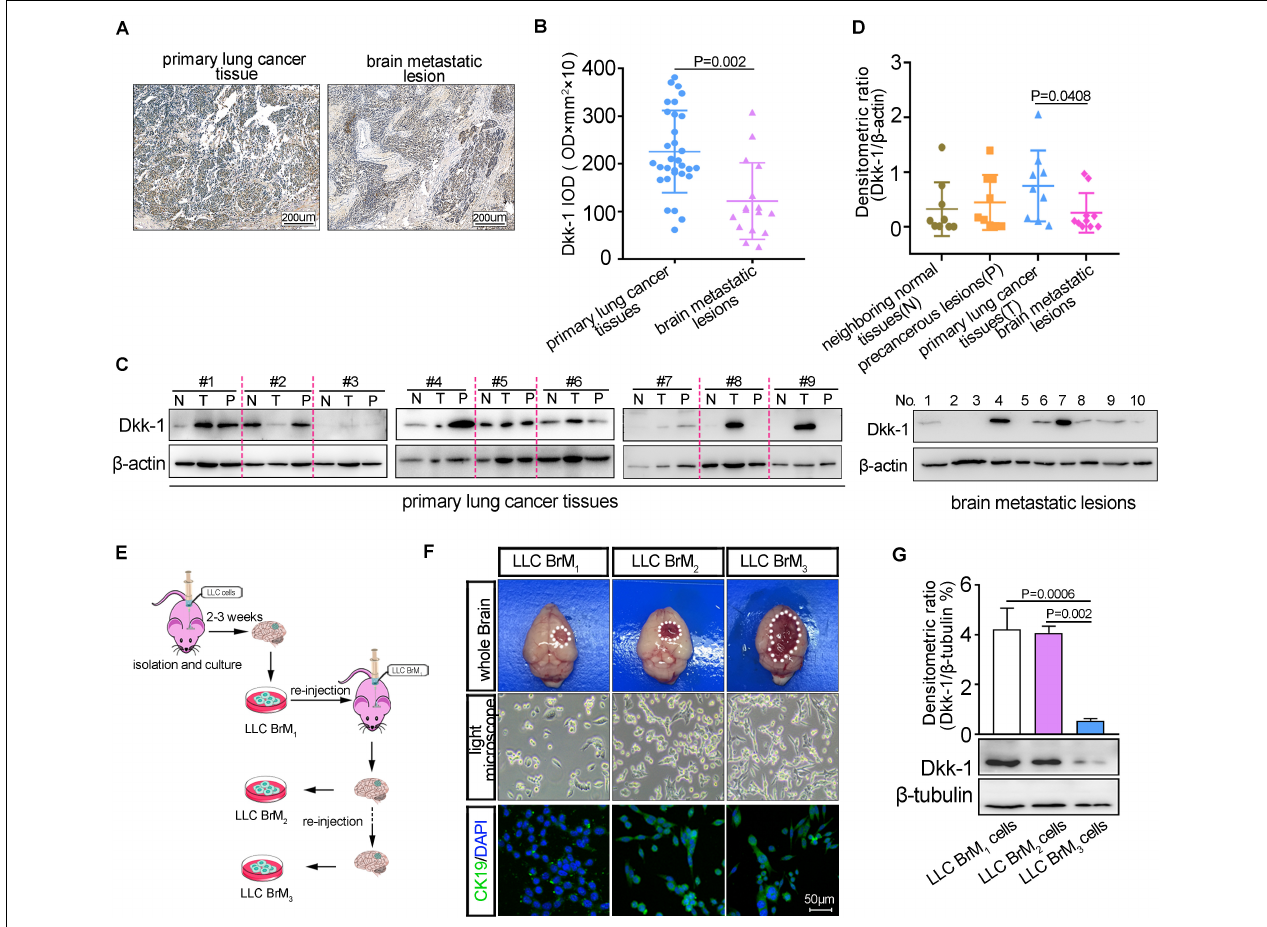
FIGURE 5 | The expressions of Dkk-1 were inversely correlated to lung cancer metastasis to brain. (A) The representative image for immunohistochemical staining of Dkk-1 in primary lung cancer tissue and the unmatched brain metastatic lesion. Scale bar, 200 µ m. (B) The statistical analysis of immunohistochemical staining for Dkk-1 in the primary lung cancers ( n = 31) and unmatched brain metastatic lesions ( n = 16). The staining intensity of Dkk-1 was quantified by average integrated optical density (IOD) values from 6 random visual fields per tissue section. (C) Left: the analysis of western blots for Dkk-1 in the 9 sets of samples, including the primary tumor sites (T), precancerous lesions ( P < 0.5 cm) and neighboring normal tissues (N < 1 cm, > 0.5 cm) obtained from the same lung cancer patient. Right: the analysis of western blots for Dkk-1 in the brain metastatic lesions from the other patients with lung cancer (BrM, n = 10). (D) The quantitative analyses of densitometric values of blots (data in C , normalized to the levels of β -actin.) from 9 sets of samples derived from lung cancer patients and the brain metastatic lesions derived from the other lung cancer patients (BrM, n = 10). (E) Schematic illustration of in vivo selection of highly brain metastatic derivative lung cancer cells (LLC BrMs). (F) The identification of in vivo selection of highly brain metastatic derivative cells. Fourteen days after orthotopic brain injection of LLC BrM cells, the representative images of the tumor mass in mice brains were shown by the white circle. The brain sections were subjected to histological analyses by light microscope and immunofluorescence staining for CK19, as a marker of LLC cells. Scale bar, 50 µ m. (G) The expressions of Dkk-1 in three rounds brain metastatic derivative cells were detected by western blot. β -actin was used as the loading control. The densities of Dkk-1 were quantified using Image J software and the results were presented as the amounts of Dkk-1 normalized against β -tubulin. A representative blot was shown in the